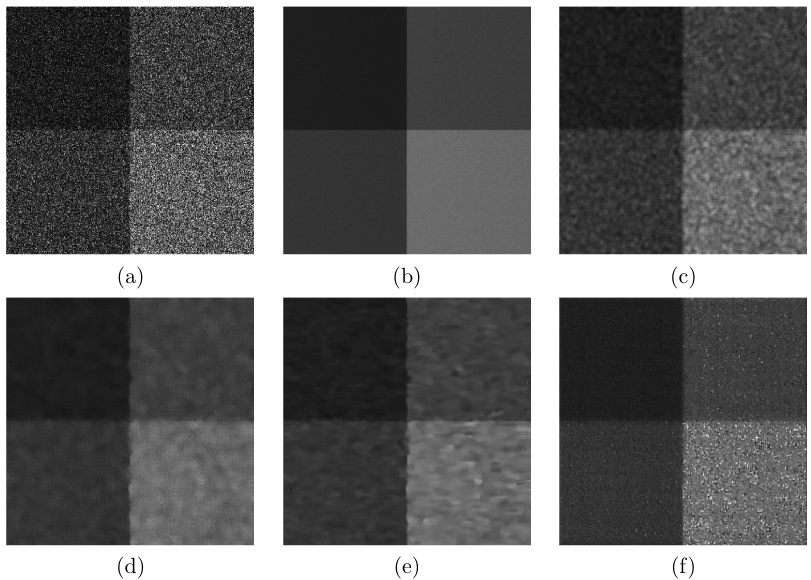
Figure 4. Squares test case: visual comparison between: ( a ) noisy SAR image, ( b ) clean, ( c ) Kuan, ( d ) PPB-it, ( e ) FANS, and ( f ) EWF.